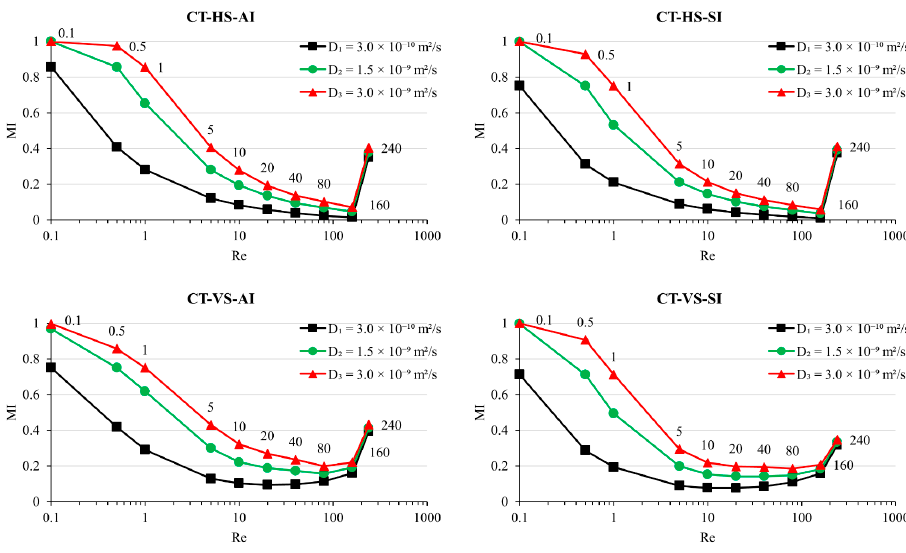
Figure 6. MI vs. Re for three different molecular diffusion constants and four CT micromixer configurations.